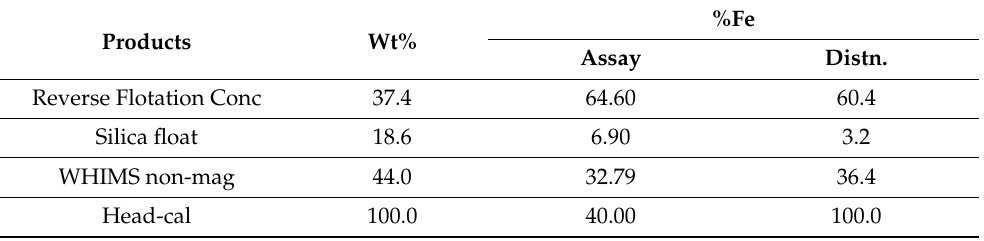
Table 5. Results of the final WHIMS test followed by flotation of the WHIMS concentrate.